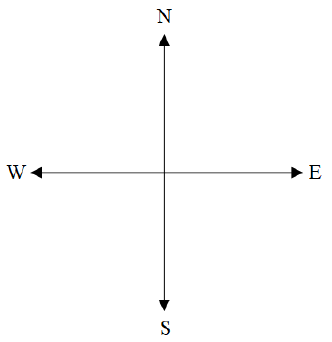
Figure 1. Solve the gradients in the four directions.